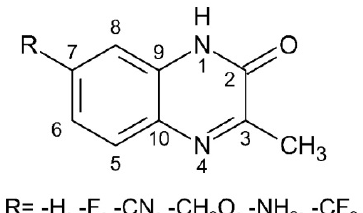
Figure 1. The structures of 3 ‐ methyl 1H ‐ quinoxalin ‐ 2 ‐ one derivatives under study.